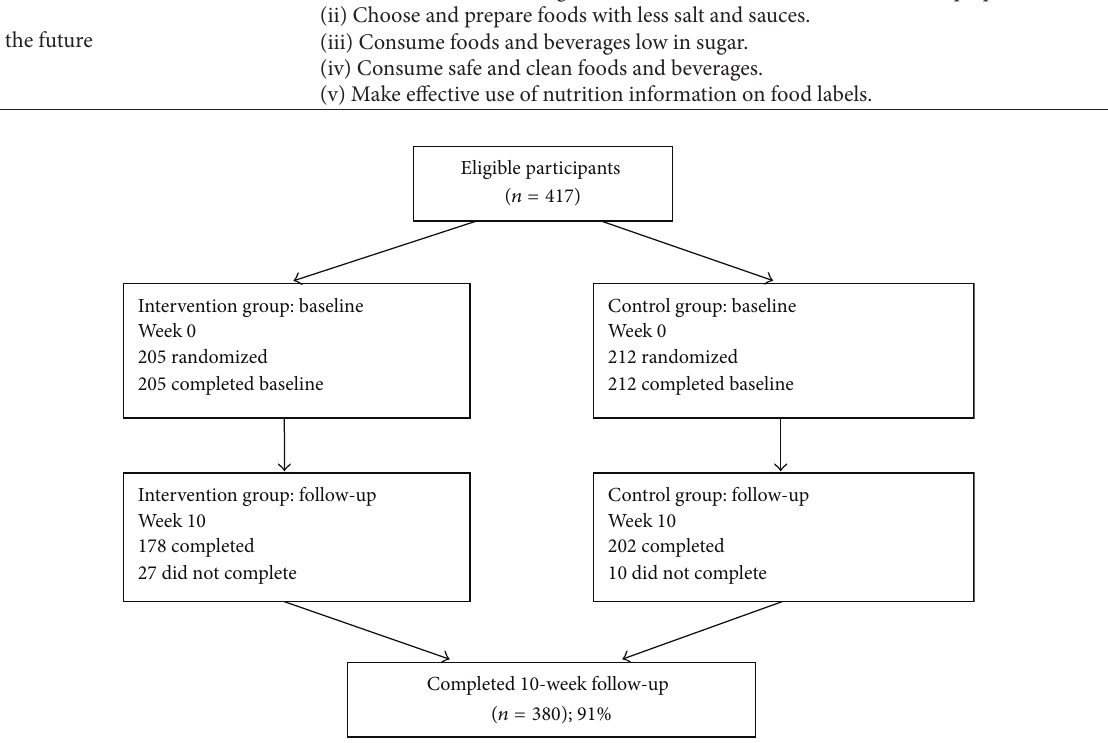
Figure 1: Consort